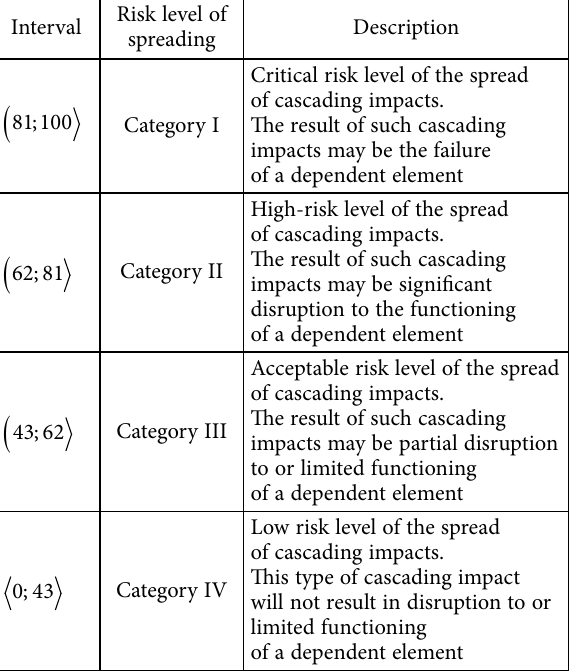
Table 5. Reference values for categorizing the level of spread of cascading